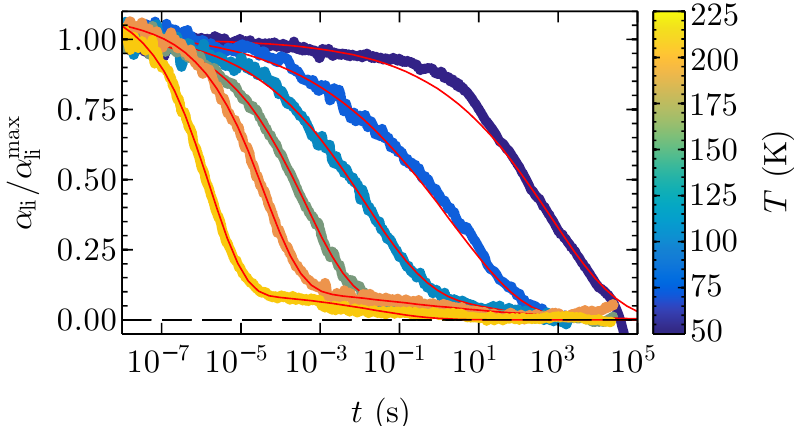
Figure 1. Normalized photo-absorptions at a wavelength of 785 nm of 6.5 mol% Mg:LN are plotted versus decay time for representative temperatures between 50 K and 225 K. The solid red curves show fits using a single Kohlrausch–Williams–Watts (KWW) stretched-exponential for T < 100K and the sum of two KWW functions for T > 100K,